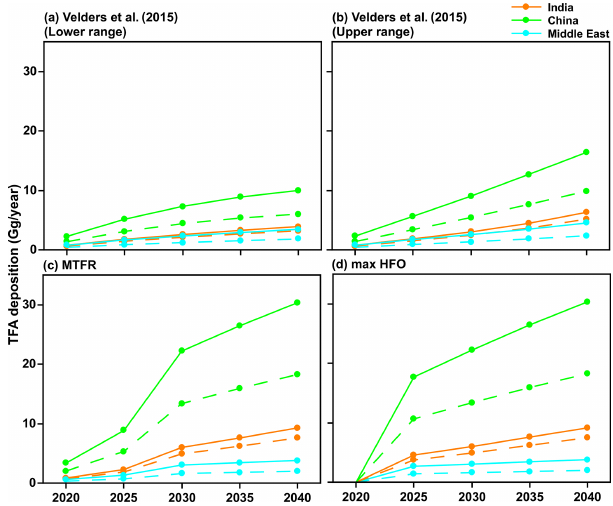
Figure 8. Total TFA deposited (dry and wet combined) in four emis- sion scenarios for 2020 to 2040 within India, China, and the Middle East domains calculated using GEOS-Chem (solid lines) and WRF- Chem (dashed lines). The values from the two models are reason- ably close for India and the Middle East, while they differ by almost a factor of 2 for